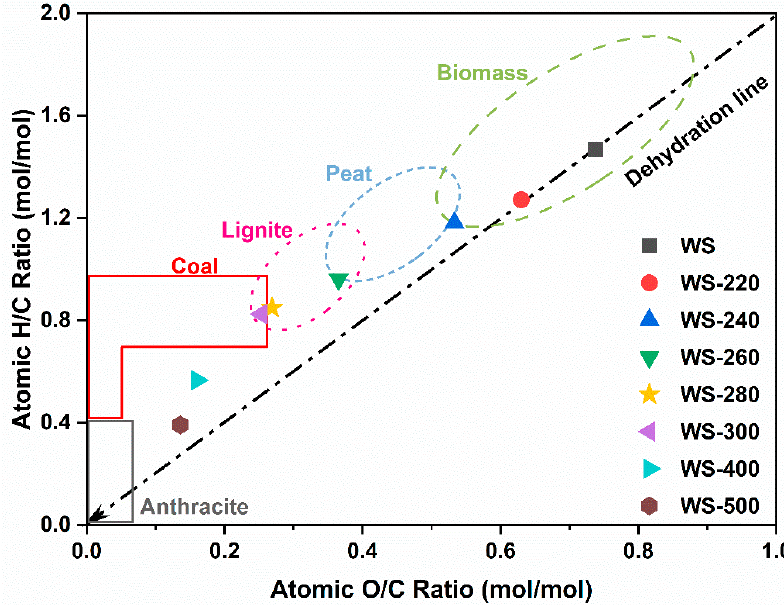
Figure 4. Van Krevelen diagram of raw WS and WS treated at various temperatures.